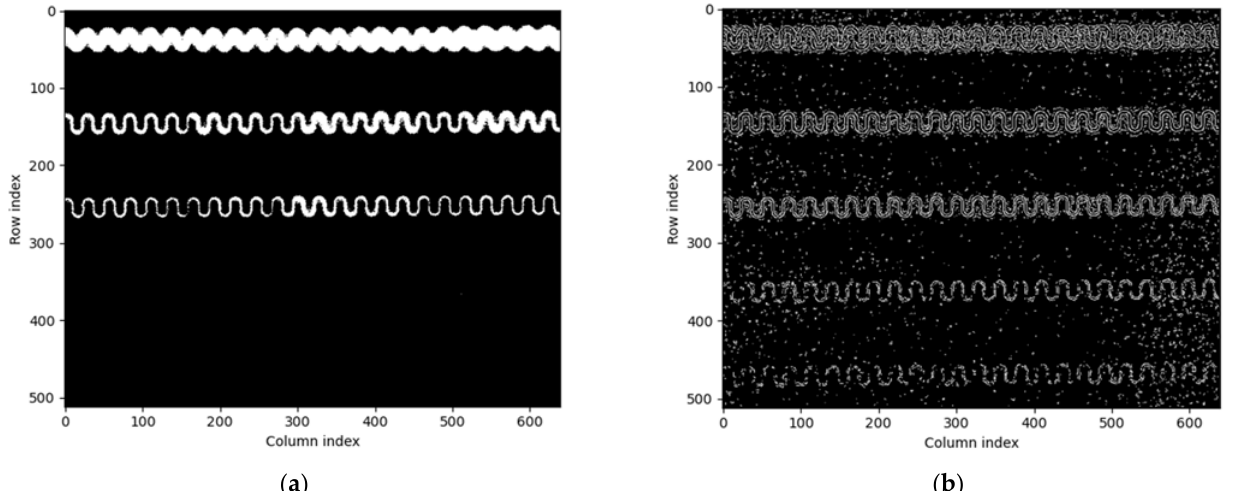
Figure 13. Demonstration of edge detection methods: ( a ) Otsu’s method; ( b ) Canny edge detector with sigma = 0.1, threshold = [0.025, 0.03].